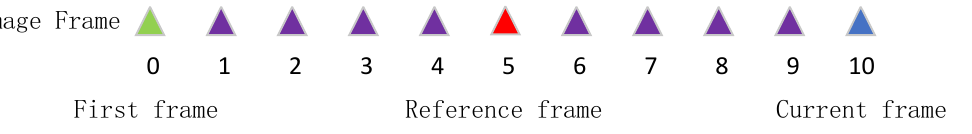
Figure 3. Image frame